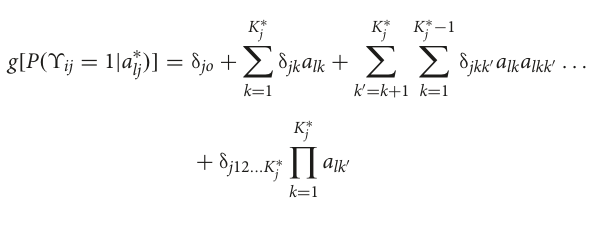
potential model misspecifications. The item response function (IRF) of G-DINA was detailed as below